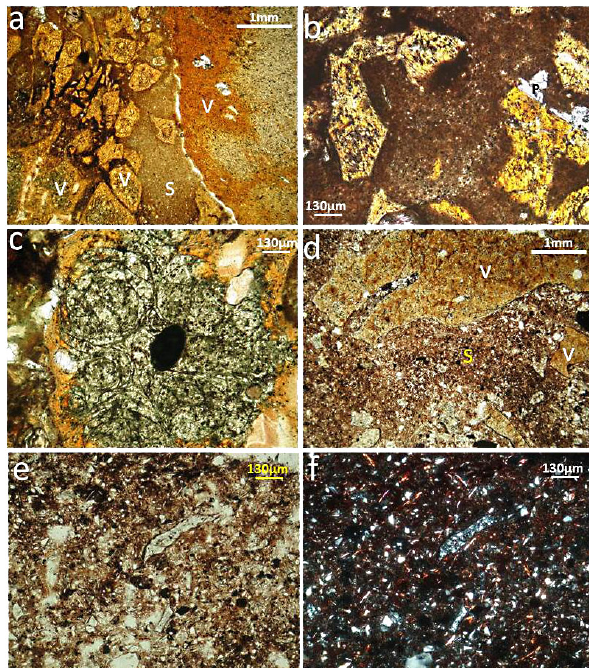
Fig. 12. Photomicrographs of peperites from the Palmas volcanic sequence, along Rota do Sol highway: ( a , b and d ) volcanic glassy clasts (V) set in a brown siltstone matrix (S); (c) volcanic clast dis- playing concentric fractures – perlitic texture - common in the two lowermost peperites; ( e and f ) detail of the poorly sorted, slightly coarser siltstone from (d) ( a , b , c , d and e – // polarizers; f – X polarizers;